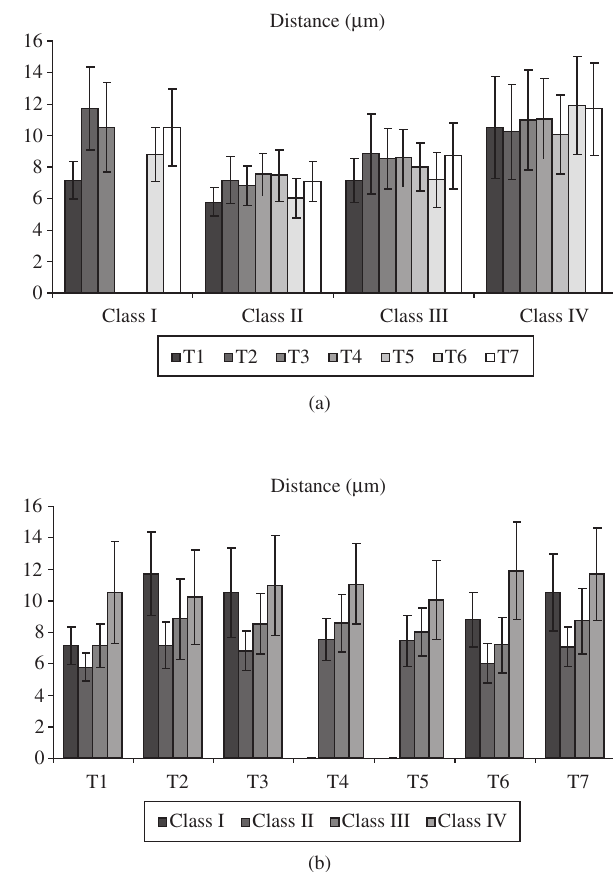
Figure 7. Distance between tubules: a) per tooth and b) per class of dentin. Figure 8. Average distance between tubules a) per class of dentin and b) per